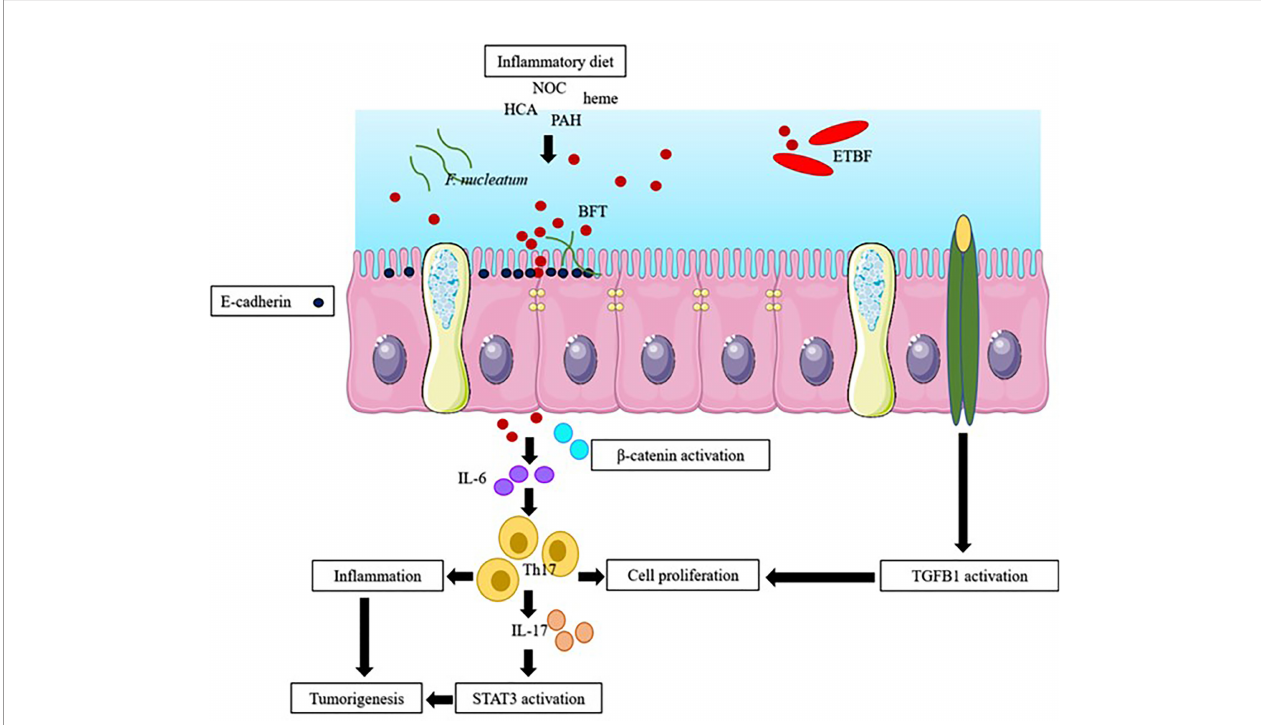
FIGURE 1 | The possible pathway of early-onset colorectal cancer (EOCRC). In fl ammatory diet (high fat and sugar diet), endogenous N-nitroso compound (NOC), polycyclic aromatic hydrocarbons (PAH), heterocyclic amines (HCA), heme, stress, F. nucleatum and B. fragilis toxin (BFT), produced by enterotoxigenic B. fragilis (ETBF), induced in fl ammation through stimulation of in fl ammatory cytokines and causes (i) the activation of b -catenin and STAT3 signaling pathway; and the activation of transforming growth factor beta 1 (TGFB1) pathway (Nakamura et al.,